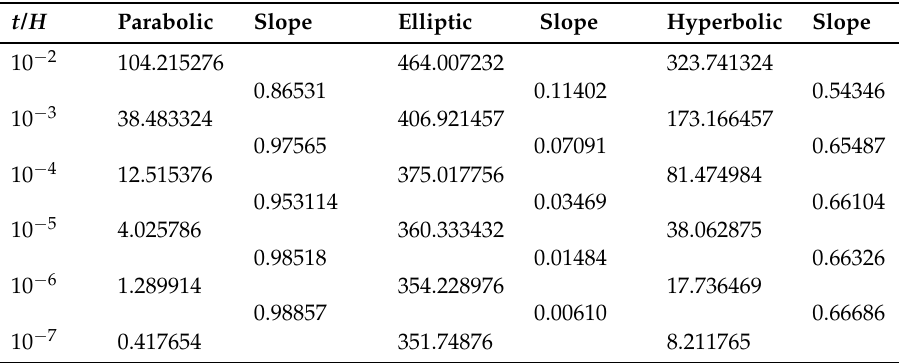
Table 1. Asymptotic analysis of fundamental frequency ω 2 elliptic , parabolic , and hyperbolic shells of revolution. Slope values for different branch values in the asymptotic regime.